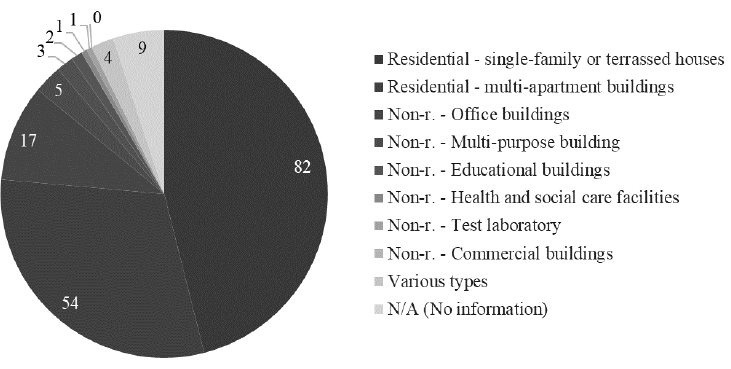
Figure 1. Types of building typology covered by the case studies (Non-r. = non-residential).